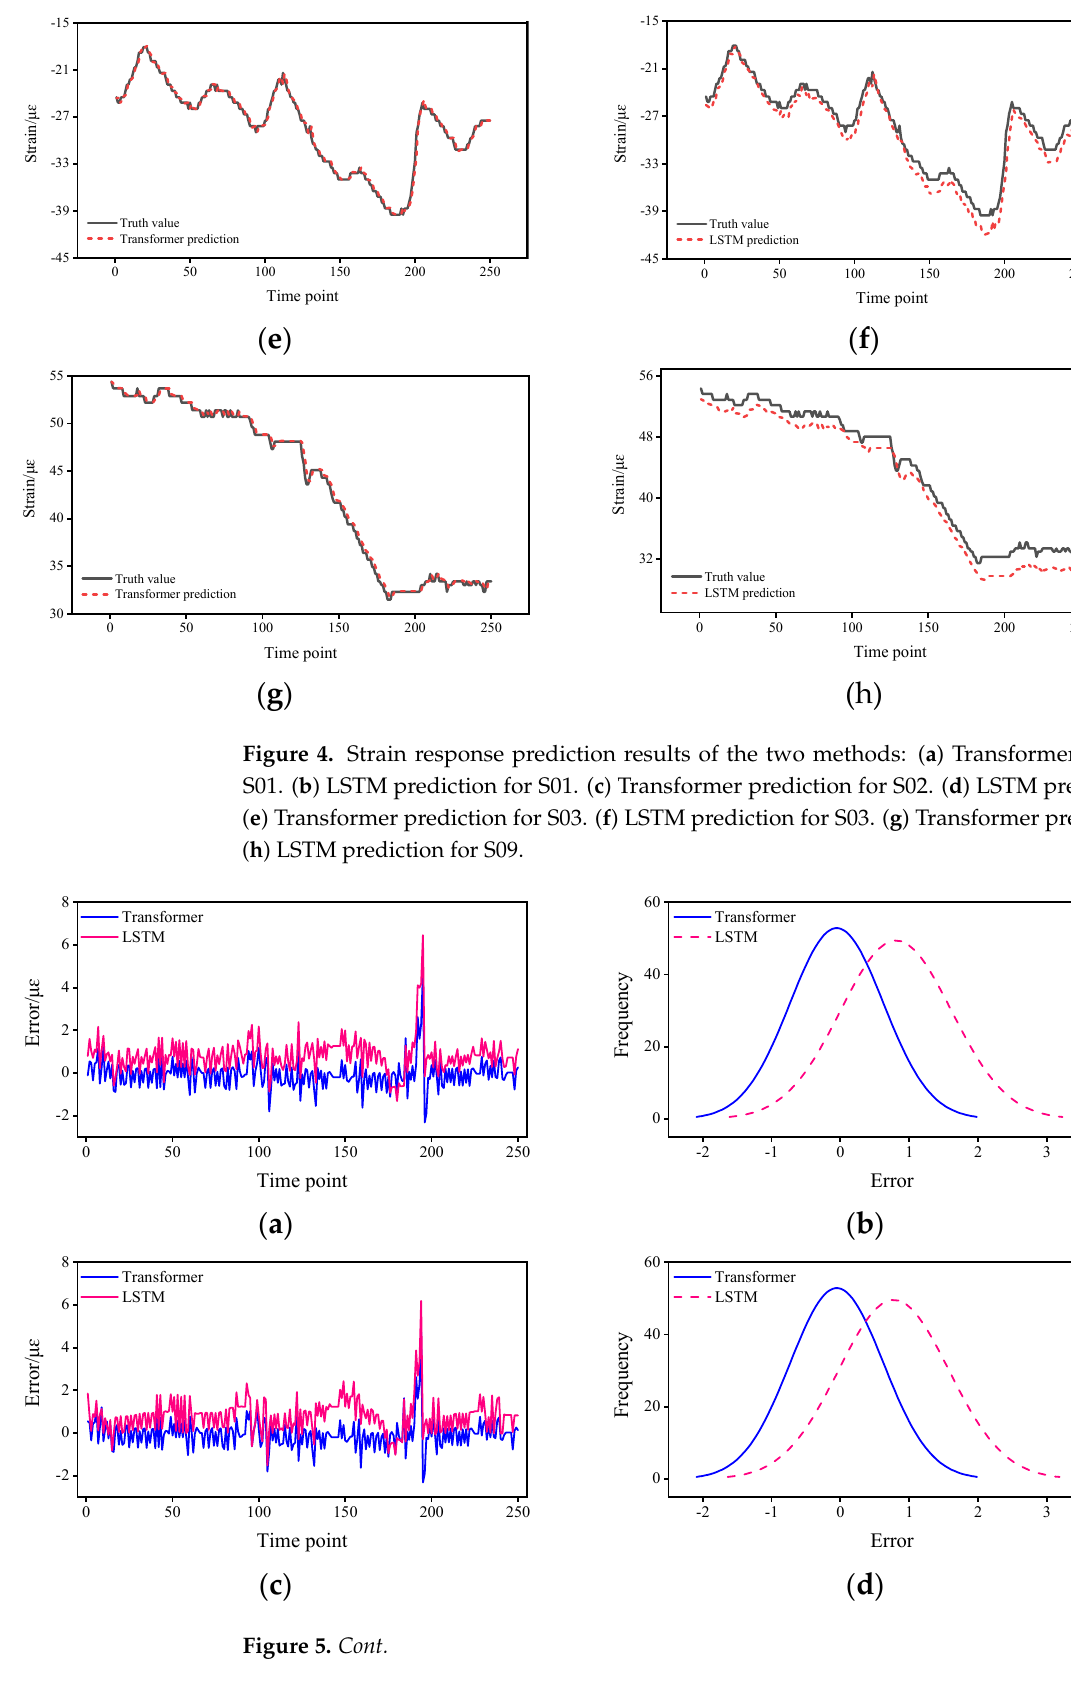
Figure 4. Strain response prediction results of the two methods: ( a ) Transformer prediction for S01. ( b ) LSTM prediction for S01. ( c ) Transformer prediction for S02. ( d ) LSTM prediction for S02. ( e ) Transformer prediction for S03. ( f ) LSTM prediction for S03. ( g ) Transformer prediction for S09. ( h ) LSTM prediction for S09.